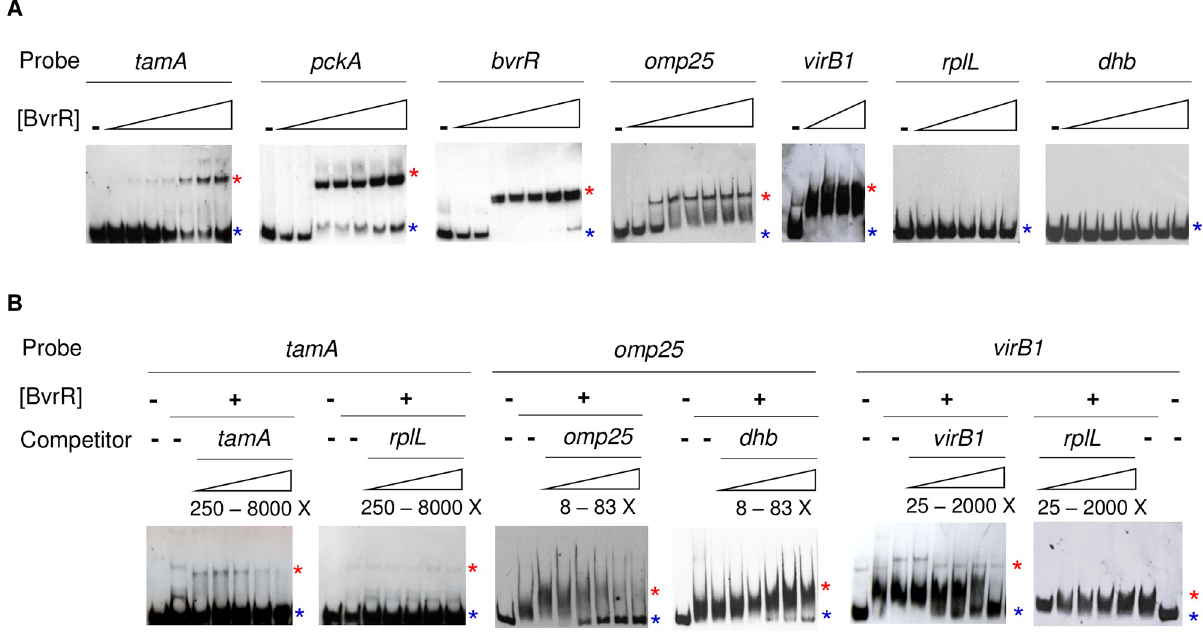
Fig 4. Biochemical confirmation of the direct binding of BvrR-P to the upstream intergenic region of selected target genes. A. Direct EMSA with the following probes: tamA , pckA , bvrR , omp25 , virB1 , and negative controls rplL and dhbR . The probes were designed based on the location of the significant ChIP-Seq signals obtained in this study and previous information about transcriptional units and promoter structures when available [24, 42, 78]. Protein concentrations for each experiment varied from 0.05 to 2.6 μ M. B. Competitive EMSA using increasing concentrations of free probe (competitor). The protein concentration was 0.6 μ M. Red asterisks represent the migration pattern of a protein-DNA complex (shift). Blue asterisks represent the migration pattern of a free probe (no shift). Experiments in panels A and B are independent of each other. All gels have either negative (probe without protein) or positive controls (probe with protein) to compare. These results are representative of at least three independent experiments.